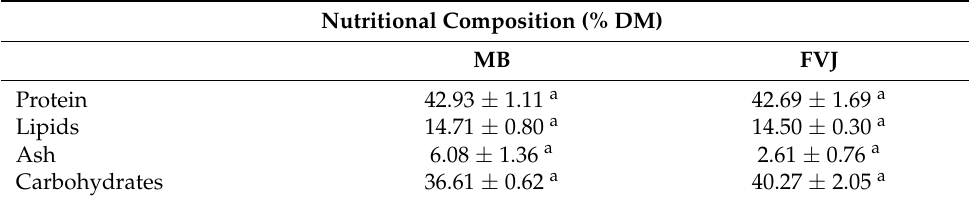
Table 7. Nutritional composition of Chlorella protothecoides biomass grown in fed-batch